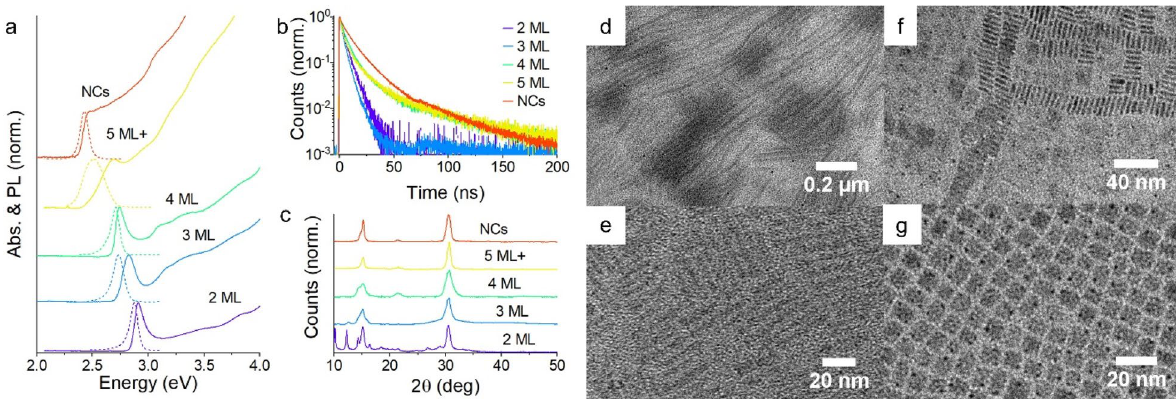
Fig. 1 a Absorption (solid lines) and photoluminescence (dashed lines) of CsPbBr 3 NPLs and NCs. b Time-resolved photoluminescence of the same samples. c Powder X-ray diffraction of drop-cast solids of the same samples. d Lamellar strands of 2 ML NPLs at low magnification. e , f Higher magnification images of e 3 ML NPLs, f 4 ML NPLs, and g